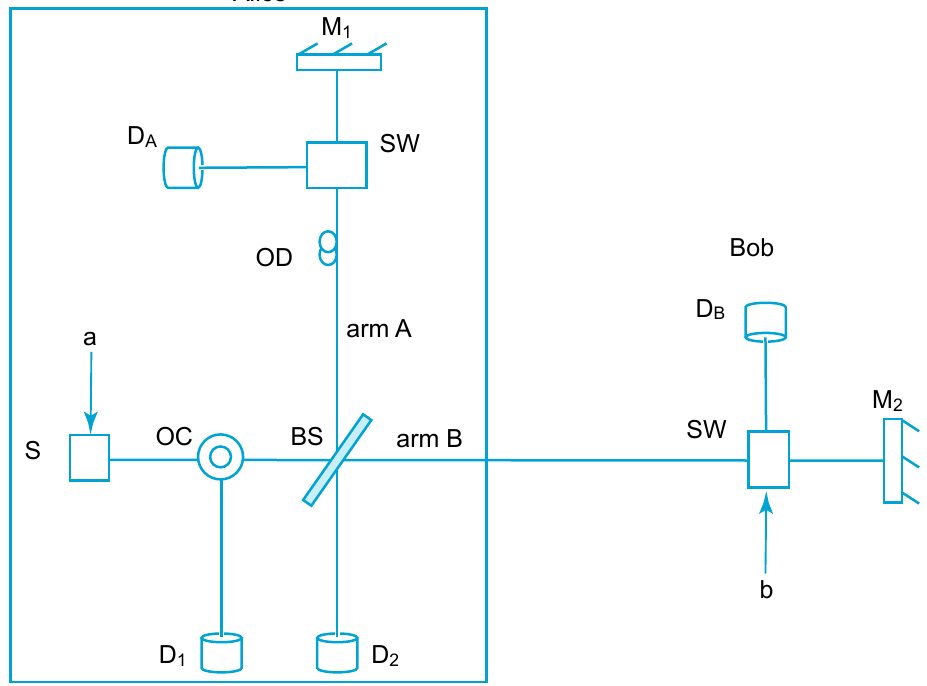
Figure 1: Basic set-up for counterfactual [24] or semi-counterfactual [104] quantum key distribution based on a Mach–Zehnder interferometer. Alice’s station consisting of the source (S) initiates the protocol by sending light pulses through the optical circulator (OC) to the beamsplitter (BS), which splits them into beams along arms A and B. The optical delay (OD) maintains the phase between the arm by compensating for the path di ff erence in the two arms. Light along arm A is subjected to absorption by detector D A or reflection from mirror M 1 by Alice based on her switch (SW) state. Likewise by Bob along arm B who also possesses a switch (SW), a detector D B and a mirror M 2